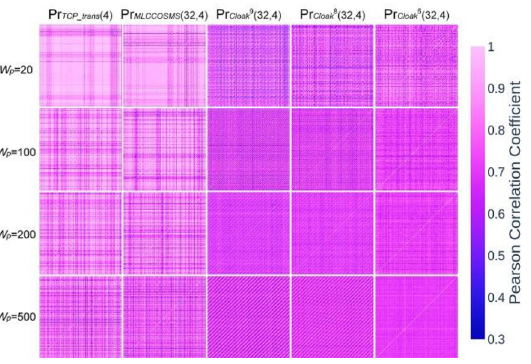
Fig 9. Heatmaps of Pr TCP_trans (4) , Pr MLCCOSMS (32,4) , and Pr